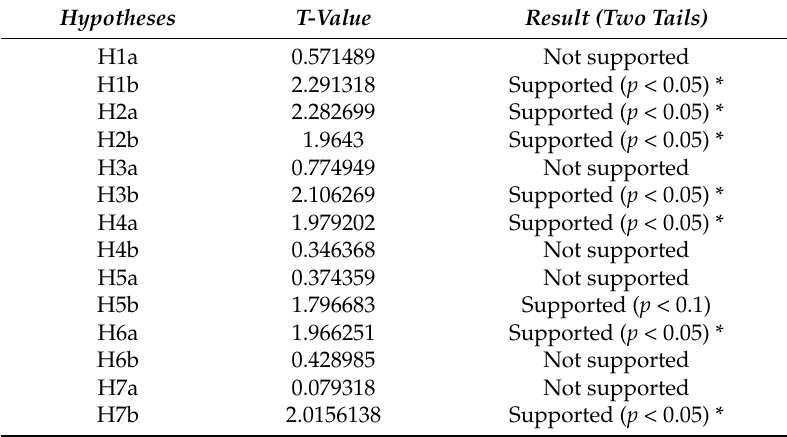
Table 3. Hypotheses testing